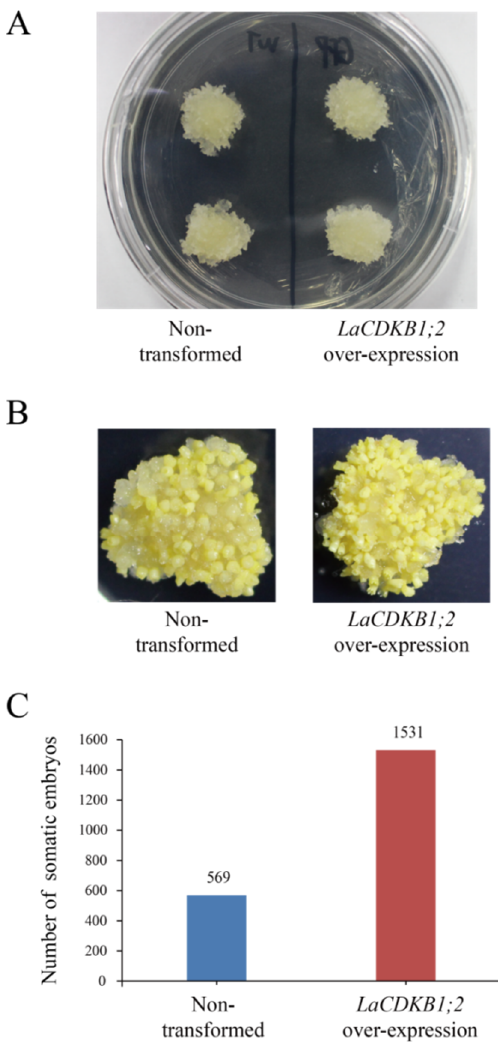
Figure 8. Characterization of L. kaempferi transgenic ( LaCDKB1;2 over-expression) cultures. ( A ) Non- transformed and LaCDKB1;2 overexpression S287 cultures of the same weight (0.5 g) were cultured on a solid maturation medium in a plate for 42 days and then used to analyze the morphology ( B ) and number ( C ) of somatic embryos. Data are presented as the total number of somatic embryos generated from 10 plates of culture.